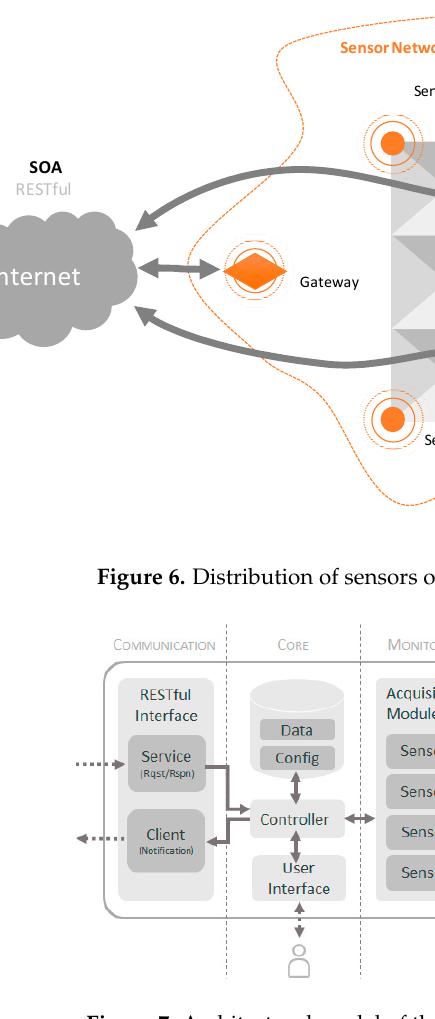
Figure 7. Architectural model of the sensors.